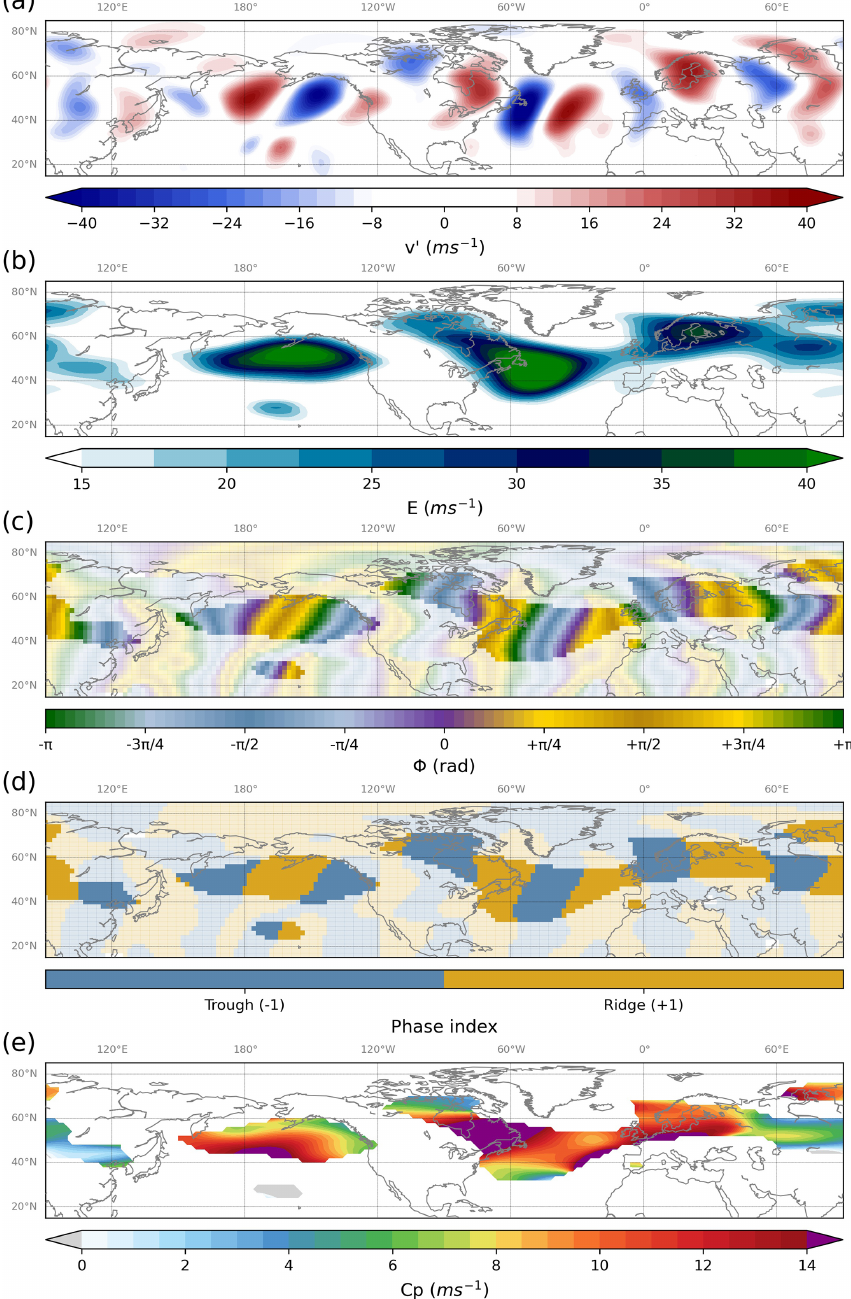
Figure 1. Upper-tropospheric flow diagnostics based on the ERA5 300hPa meridional wind anomaly ( v (cid:48) ) field on 22 September 2018 at 00:00UTC: (a) spatially filtered v (cid:48) , (b) amplitude ( E ), (c) phase ( Φ ), (d) phase index (ridges: + 1, troughs: − 1), and (e) zonal phase speed ( c p ). Opaque colours in panels (c) and (d) indicate the areas where RWP objects are